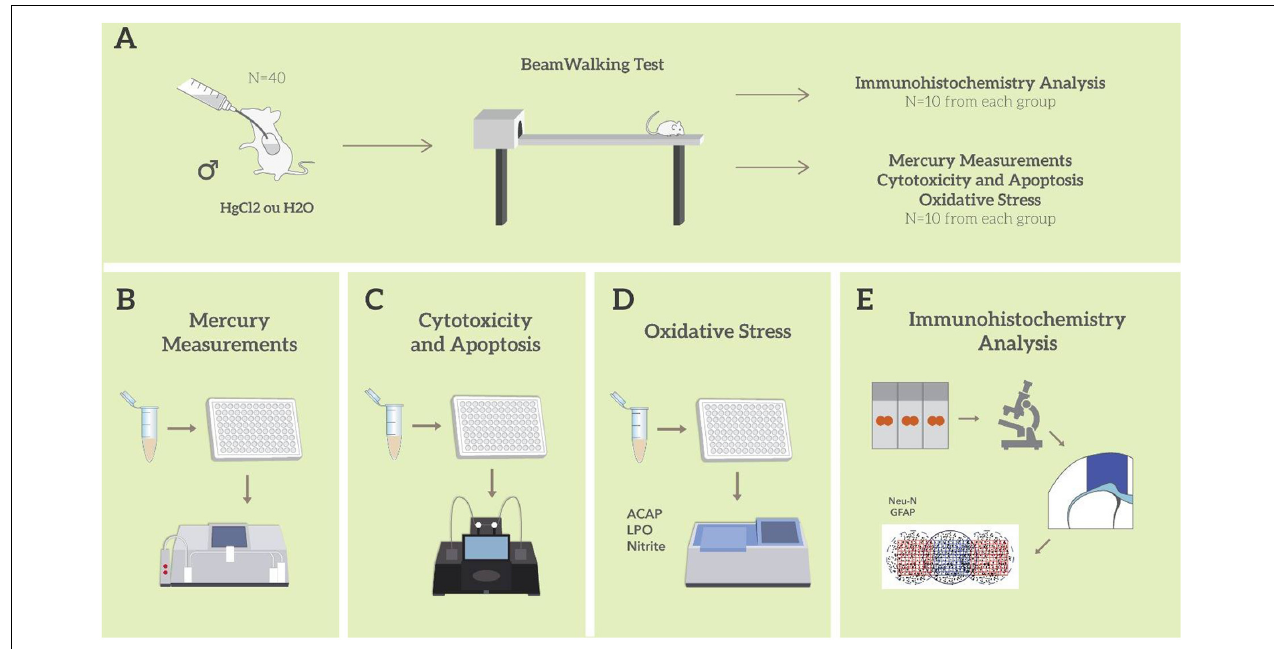
FIGURE 1 | Sample description and experimental stages. Description of the sample and model of exposure to HgCl 2 ; Beam walking motor test; division of experimental groups and animal destinations for each stage of analysis (A) ; total mercury measurement assay (B) ; evaluation and quantification of cytotoxicity and apoptosis (C) ; oxidative balance assays (D) ; immunohistochemistry and morphometric analysis (E) . All tissue and biochemical assays were performed in